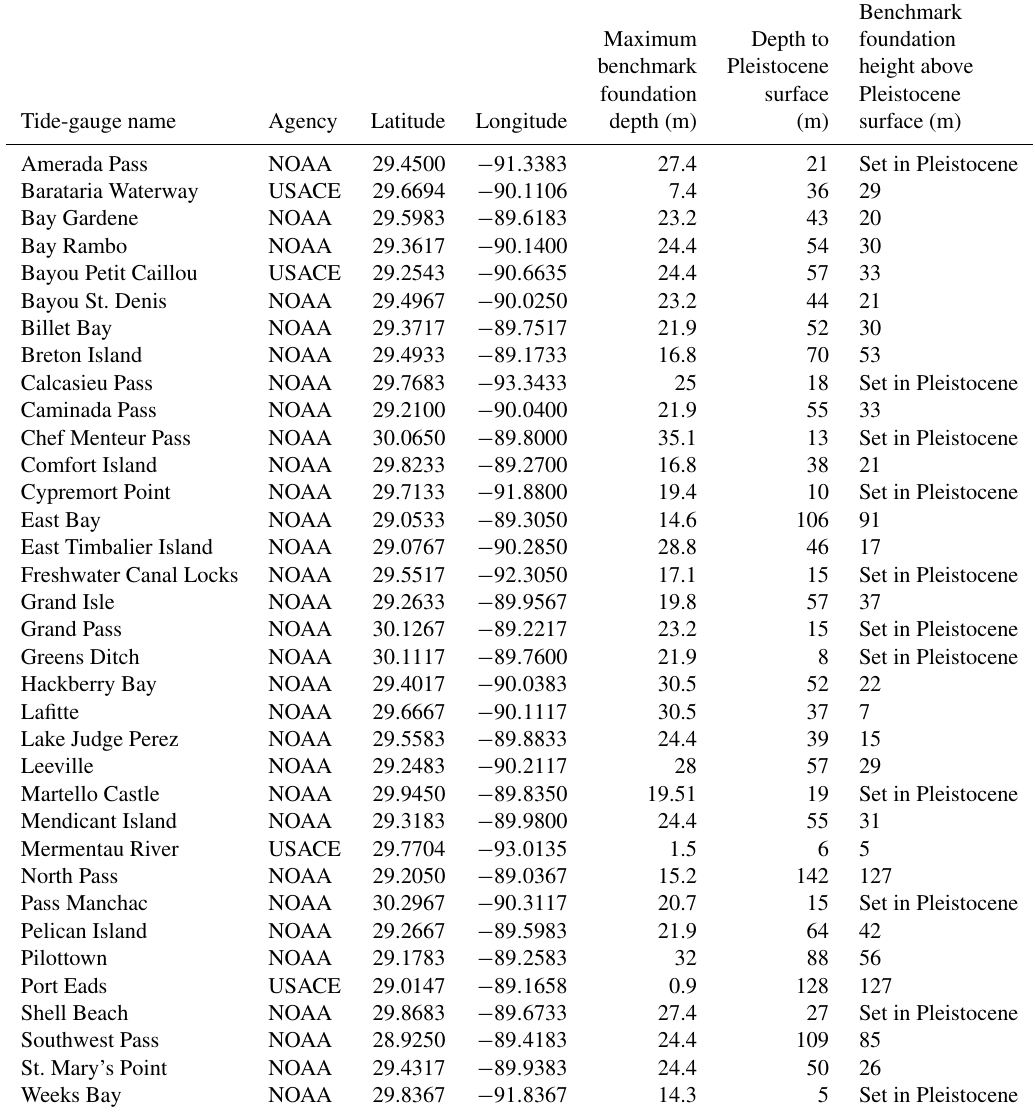
Table 1. Tide gauges in the Holocene landscape of coastal Louisiana with known foundation information ( n = 35).